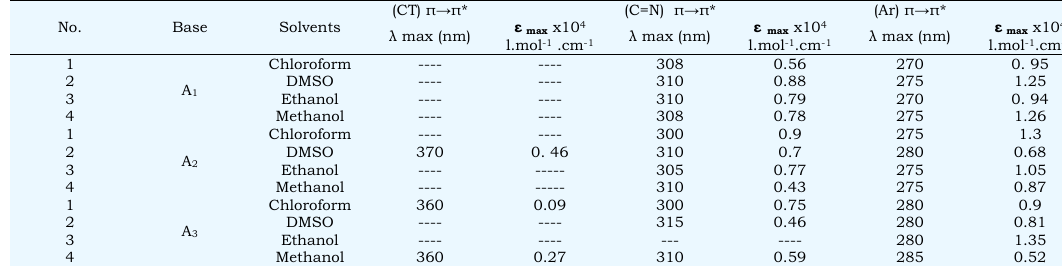
Table 2. The values of the solvents, the dipole moment constants and the maximum wavelengths of (A 1 ), (A 2 ) and (A 3 ).